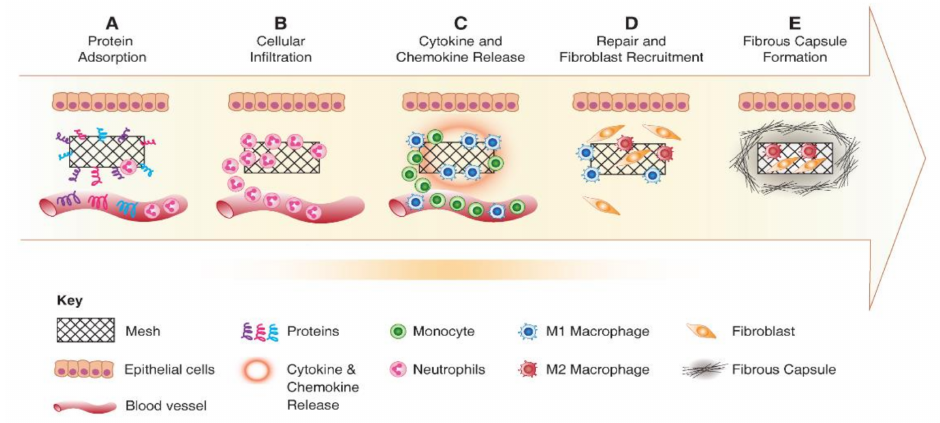
Figure 5. Schematic showing the foreign body response to implanted biomaterial . ( A ) Protein adsorption; ( B ) cellular infiltration; ( C ) chronic inflammation; ( D ) fibroblast recruitment and matrix deposition; ( E ) fibrous capsule formation. Reused with permission from